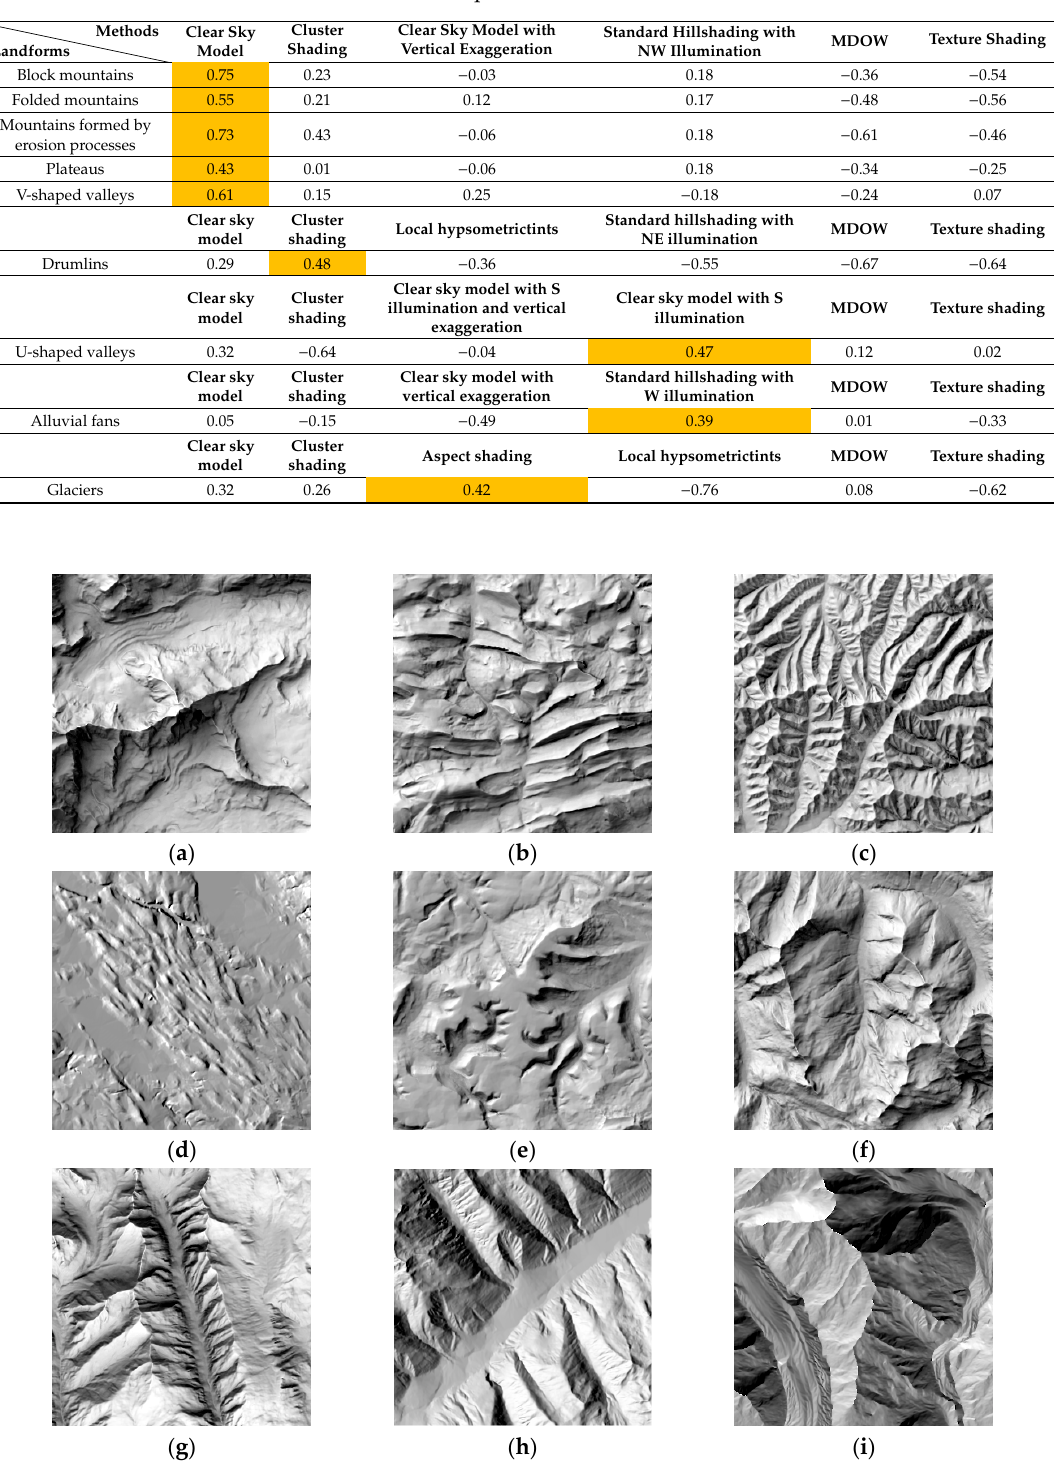
Figure 16. The most suitable relief shading methods per landform based on the survey results: the clear sky model method for ( a ) block mountains; ( b ) folded mountains; ( c ) mountains formed by erosion processes; ( e ) plateaus; and ( f ) V-shaped valleys; ( d ) the cluster shading for drumlins; ( g ) the clear sky model with custom (here S) illumination for U-shaped valleys; ( h ) the standard hillshading with custom (here W) illumination for alluvial fans; and ( i ) the aspect shading for glaciers.